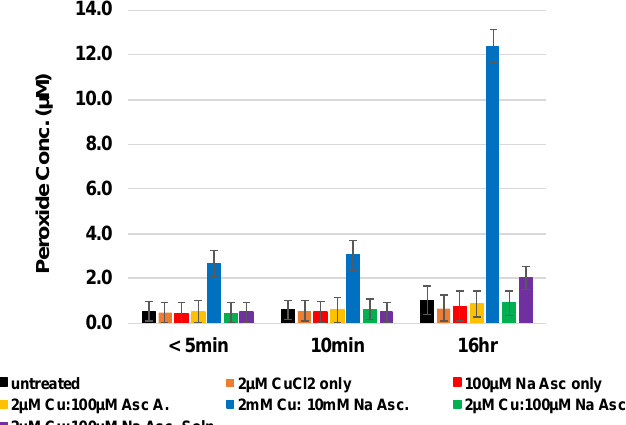
Figure 2. Nonwoven HE 100% greige cotton fabric Pad-Dry treated with copper chloride in sodium ascorbate solution concentrations listed in Table 2 compared to previous fabric adsorbed concentration as a control.